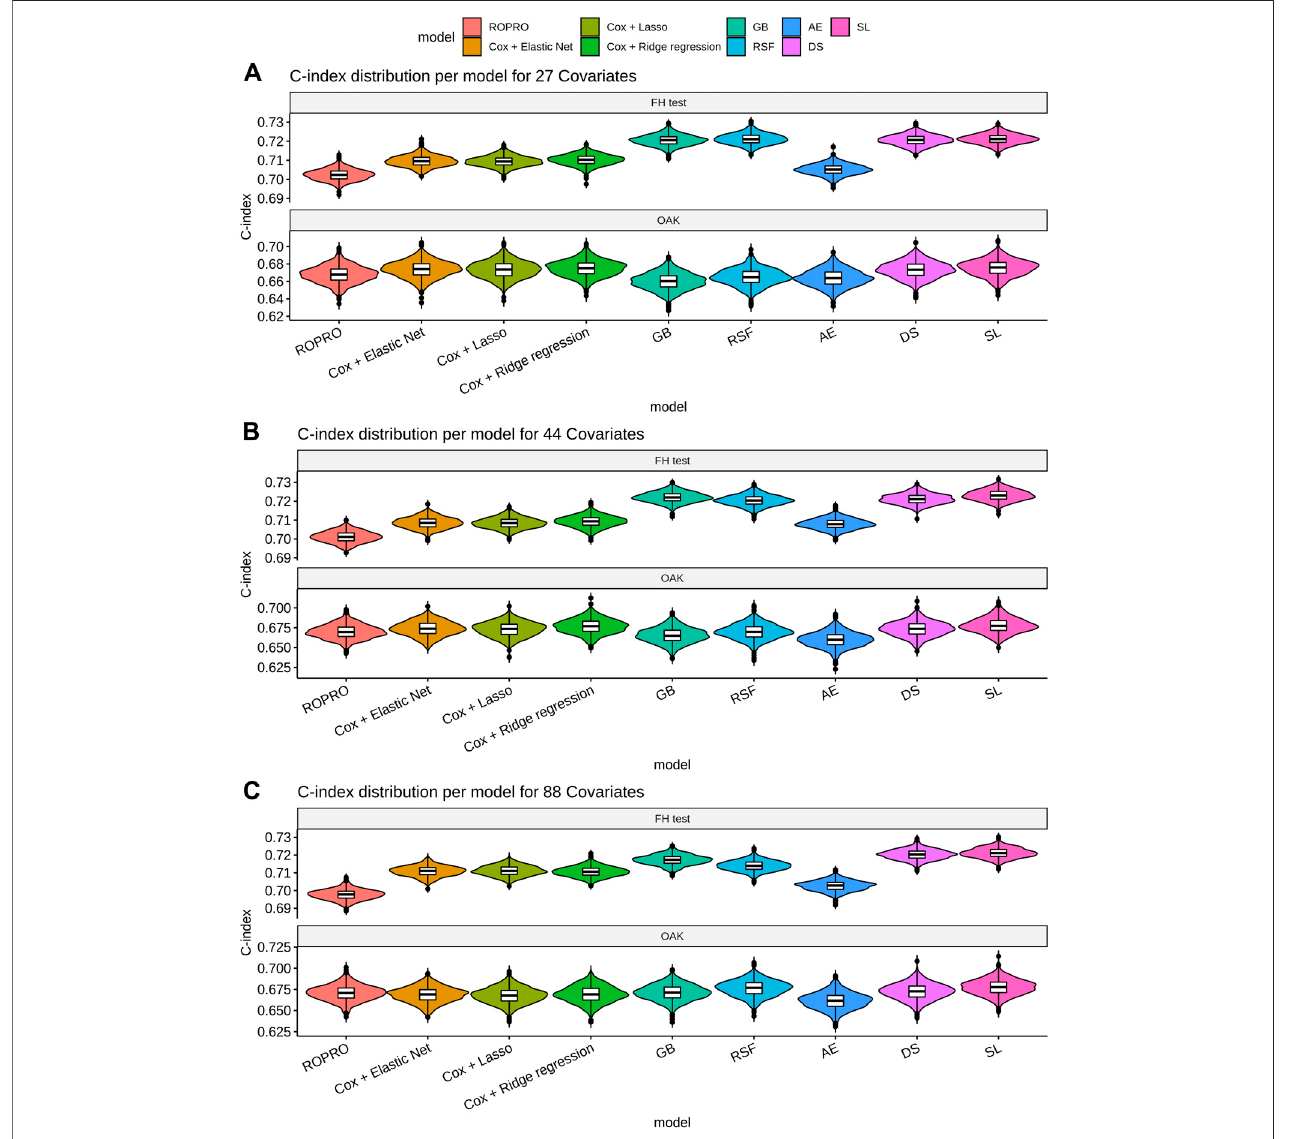
FIGURE 6 | Violin plot of the C-index in the FH test dataset (top) and OAK III (bottom) . The C-index results for the 27, 44 and 88 covariate sets are illustrated in Figure (A) – (C) , respectively. The plot displays the distribution and a box-plot of the C-index. Bootstrap was used to determine the distribution of the